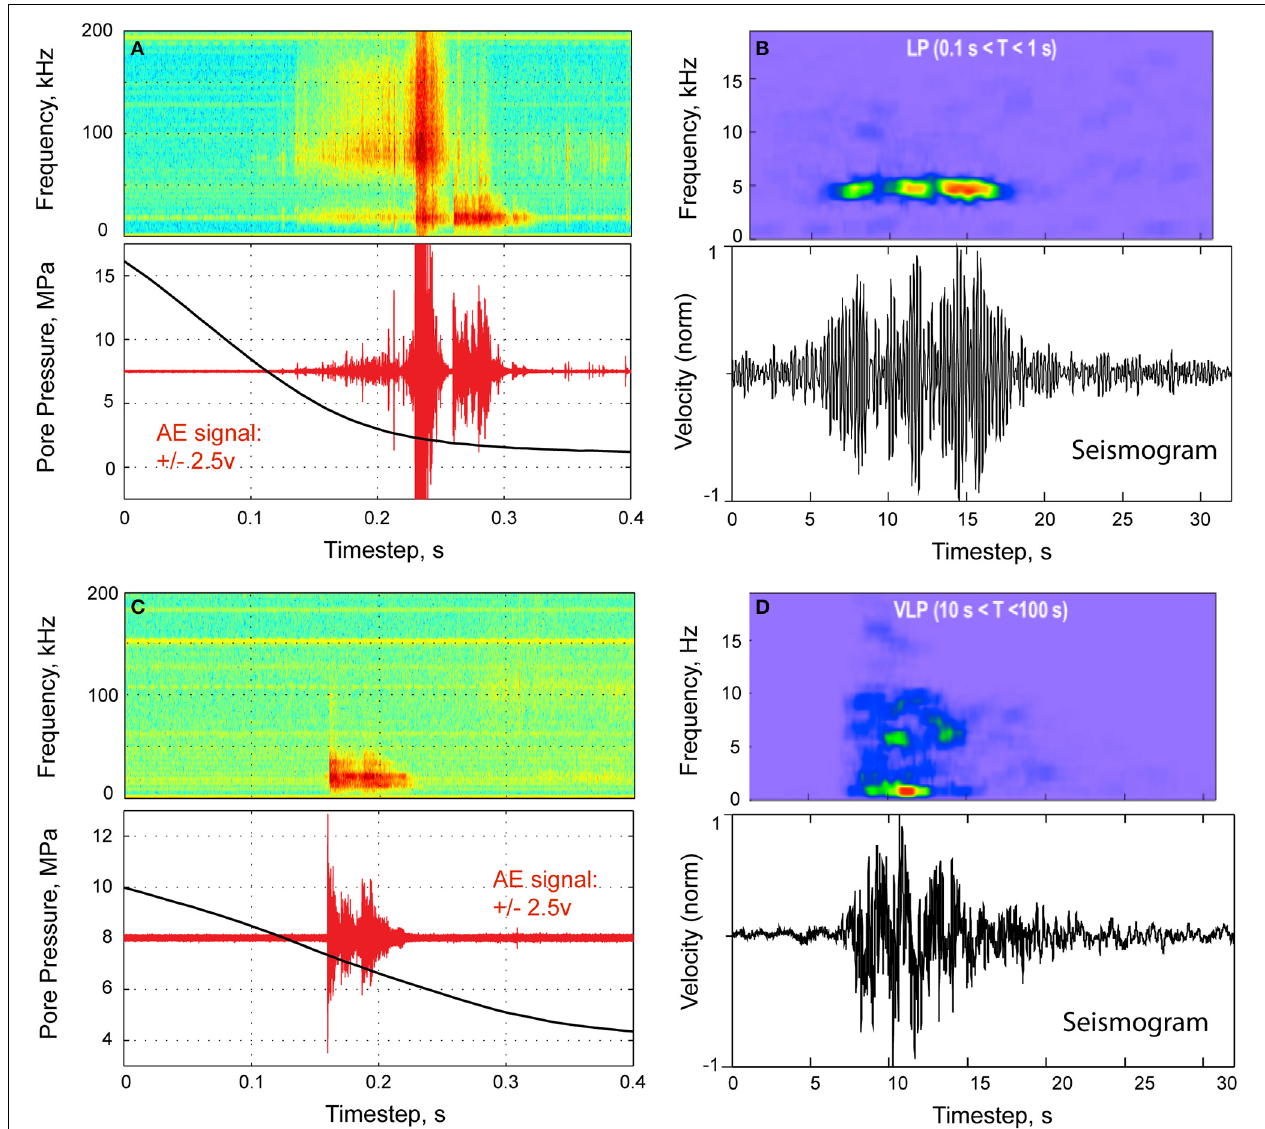
FIGURE 2 | (A) During our experiment with high temperature (175 ◦ C) pore fluid (water), we observe that as pore pressure (black line) decreases through 2MPa, the Low Frequency (LF) Acoustic Emission (AE) swarm undergoes a transition to Very Low Frequency (VLF) activity, seen as a switch from ∼ 90 to ∼ 20KHz. (B) Laboratory data from (A) may be qualitatively compared to LF data from Nisyros volcano (Caliro et al., 2005). (C) Shows the experiment